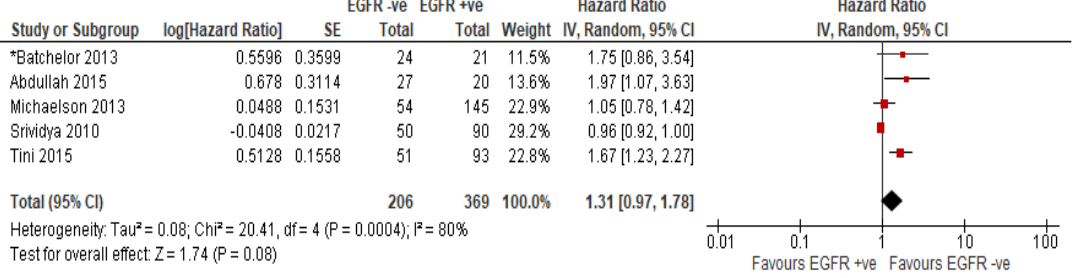
Figure 4. The association of OS with EGFR amplification or EGFR overexpression [20,22,37,41,42]. * Treatment type = chemoradiotherapy + TKI; Size of the red square indicates the relative weight of the study as it contributes to the results of the overall comparison. The diamond at the bottom of the forest plot shows the result when all the individual studies are combined and averaged. The effect measure used was HR, where values greater than 1.0 indicate that patients with EGFR amplification or EGFR overexpression has high risk of mortality than patients with no EGFR amplification or EGFR overexpression and vice versa for values less than 1.0. Note: expression of EGFR was determined by immunohistochemistry.